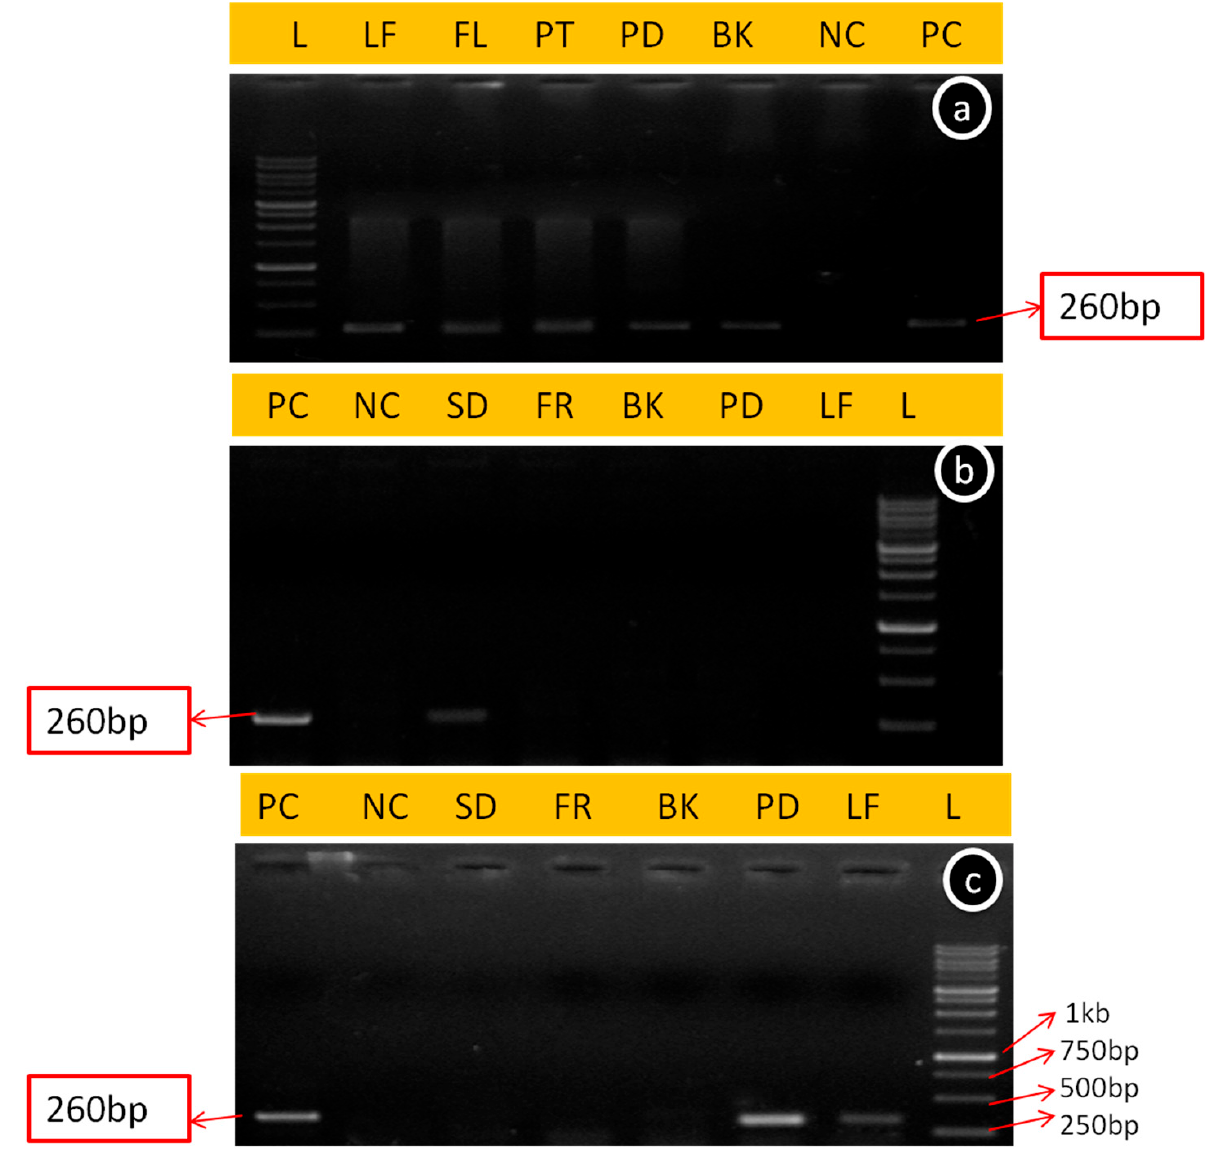
Figure 3. Amplicon of 260 bp amplified from ApMV-infected tissues of cultivar Golden Delicious (GD) plant tissues by conventional RT-PCR during the spring season ( a ), summer season ( b ) and autumn season ( c ), where L: ladder 100 bp, LF: Leaf, FL: Flowers, GD4:Bark, PT: Petals, PD: Pedicel, BK: Bark, FR: Fruit, SD: Seed, NC: Negative control, and PC: Positive control.